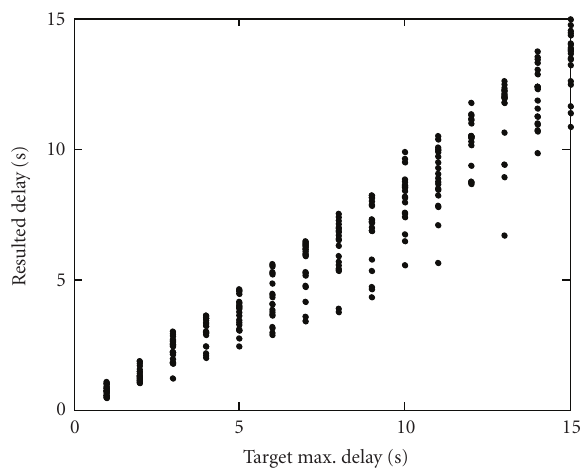
Figure 12: Resulted delay for modeled tra ffi cs versus target max delay.